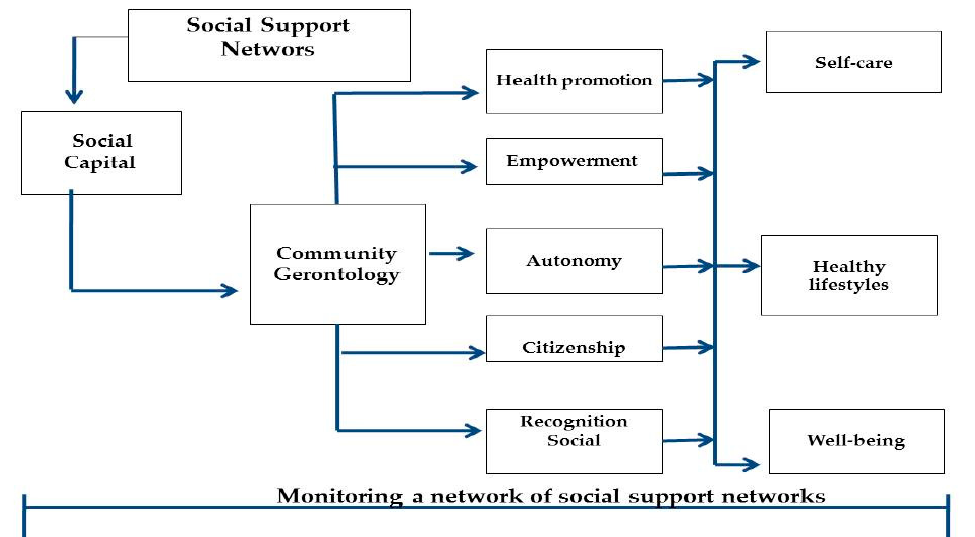
Figure 2. Characteristics of the community gerontology program (CGP). The key element of the CGP is the formation and optimal use of social support networks with the purpose of integrating a gerontological social capital, to develop community gerontology programs, establishing as pillars the promotion of health, empowerment, autonomy, citizenship, and social recognition to adopt self-care for healthy aging through the adoption and strengthening of healthy lifestyles, to maintain, prolong, or recover physical, psychological, and social functioning, within the framework of the organization and monitoring of a “network of social support networks for healthy aging”.